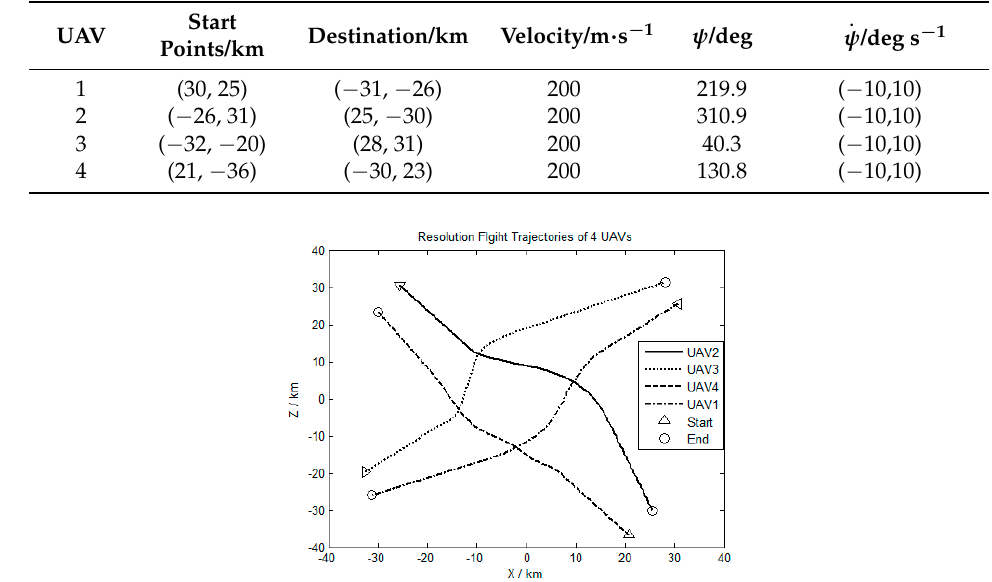
Table 2. Initial conditions and parameter values for Simulation 2.